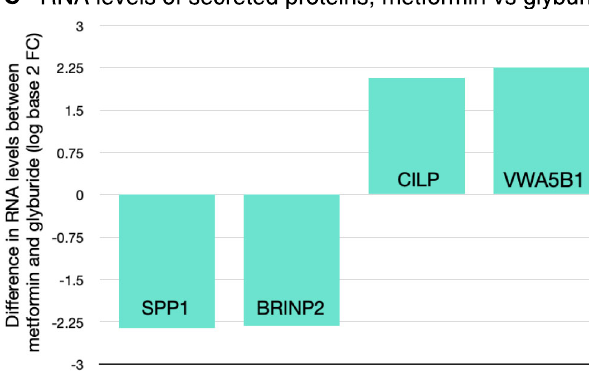
either metformin or glyburide — top 4 increased and top 4 decreased. c Genes expressing secreted proteins with greatest differential between metformin and glyburide. d SPP1 RNA levels in 4 different brain regions: AD vs. Controls. DLPFC dorsolateral prefrontal cortex, PHG parahippocampal gyrus, STS superior tem- poral sulcus, TC temporal